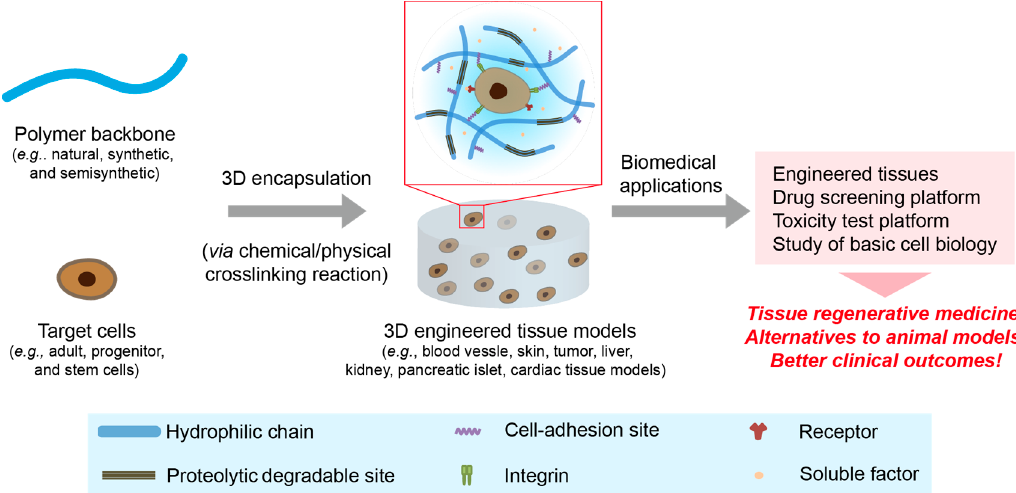
Figure 1. A schematic representation of engineered 3D tissue models for a wide range of biomedical research fields. The engineered 3D tissue models are created by encapsulating target cells via either chemical or physical crosslinking reactions. The engineered hydrogel matrices should be decorated or incorporated with proteolytic degradable sites, cell-adhesion moieties and growth factor-binding molecules to support cell growth within the matrices. Advanced tissue models have been utilized as a platform in a broad range of biomedical research fields, including the study of basic cell biology, tissue regeneration and drug screening/toxicity test platforms.